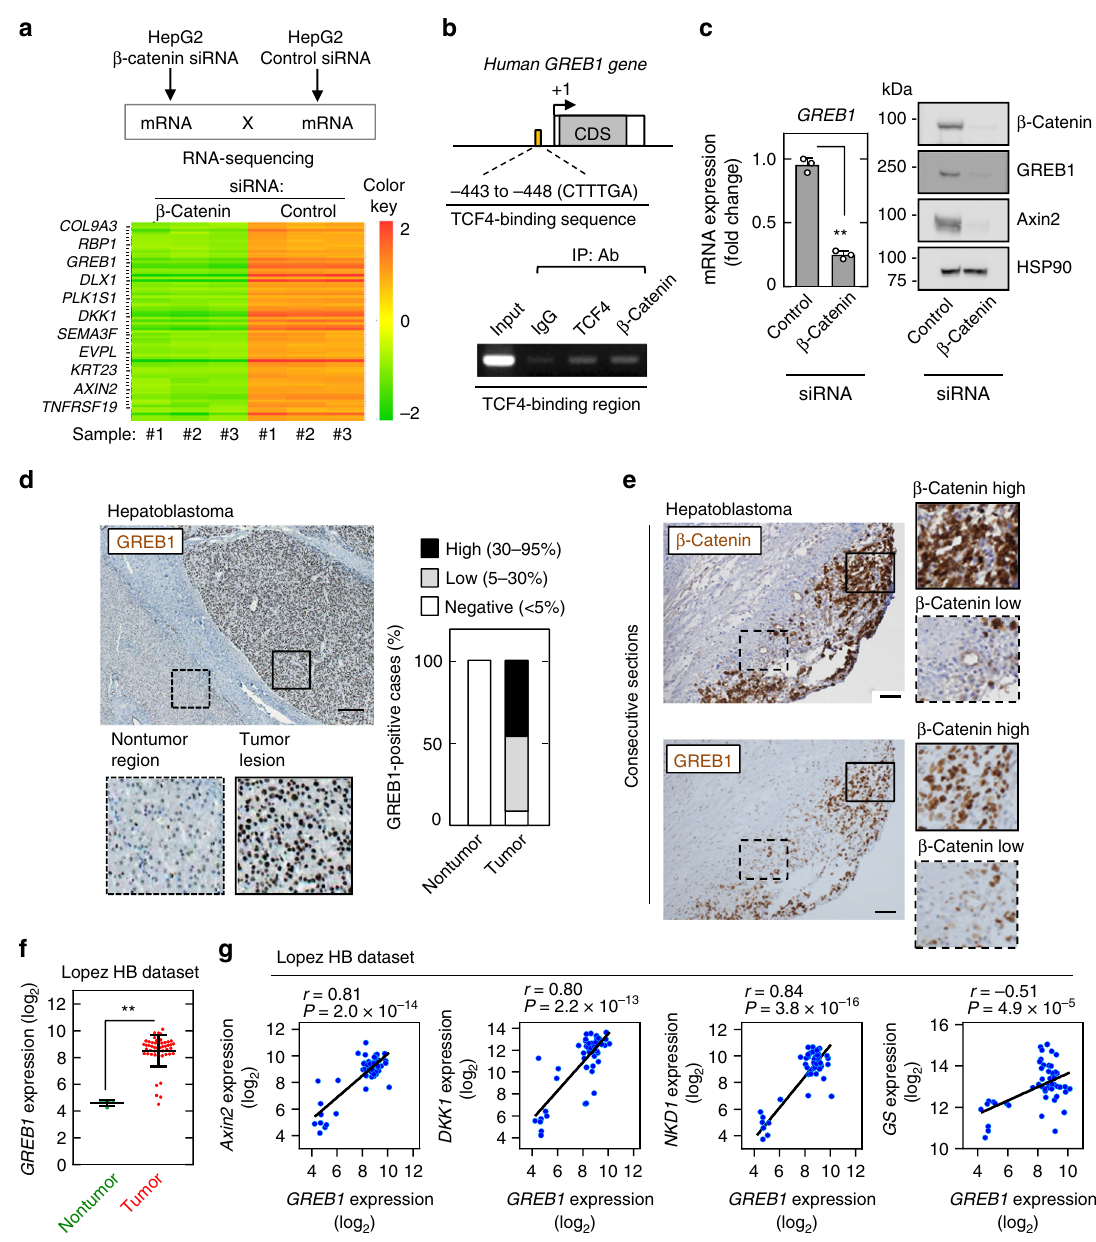
Fig. 1 GREB1 is a downstream target gene of Wnt signaling in HB. a Downstream target genes of Wnt/ β -catenin signaling in HB cells were identi fi ed by RNA-sequencing analysis. The heatmap of genes which has changed in expression in control and β -catenin knockdown cells and some candidate genes are shown in the lower panel. b Chromatin from HepG2 cells was immunoprecipitated with the indicated antibodies. The putative TCF4-binding region ( − 443 to − 448) of the precipitated GREB1 gene was analyzed by PCR with region-speci fi c primers. c HepG2 cells were transfected with control or β -catenin siRNA and real-time PCR analysis for GREB1 mRNA expression was performed. The obtained results are expressed as fold changes compared with control cells and the results shown are means± SD. Whole lysates of control and β -catenin knockdown HepG2 cells were probed with the indicated antibodies. d HB tissues ( n = 11) were stained with anti-GREB1 antibody and hematoxylin. Percentages of GREB1-positive cases in the tumor lesions and nontumor regions are shown in the right panels. Areas that stained positive for GREB1 were classi fi ed as indicated. Solid and dashed squares show enlarged images. e HB specimens were stained with the indicated antibodies and hematoxylin. Solid and dashed squares show the region where β -catenin staining is high and low, respectively. f GREB1 gene expression in 5 nontumor and 50 HB cases, which were obtained from public mRNA pro fi le dataset of HB, was analyzed. Results shown are scatter plots with means ± SD. ** P < 0.01, t test. g Scatter plots showing correlation between target genes of the Wnt/ β - catenin pathway ( Y -axis) and GREB1 gene expression ( X -axis) were obtained from the dataset of HB. The solid line indicates linear fi t. r indicates Pearson ’ s correlation coef fi cient. r value and P value were calculated with GraphPad Prism 7. Scale bars in d , 200 μ m; in e , 50 μ